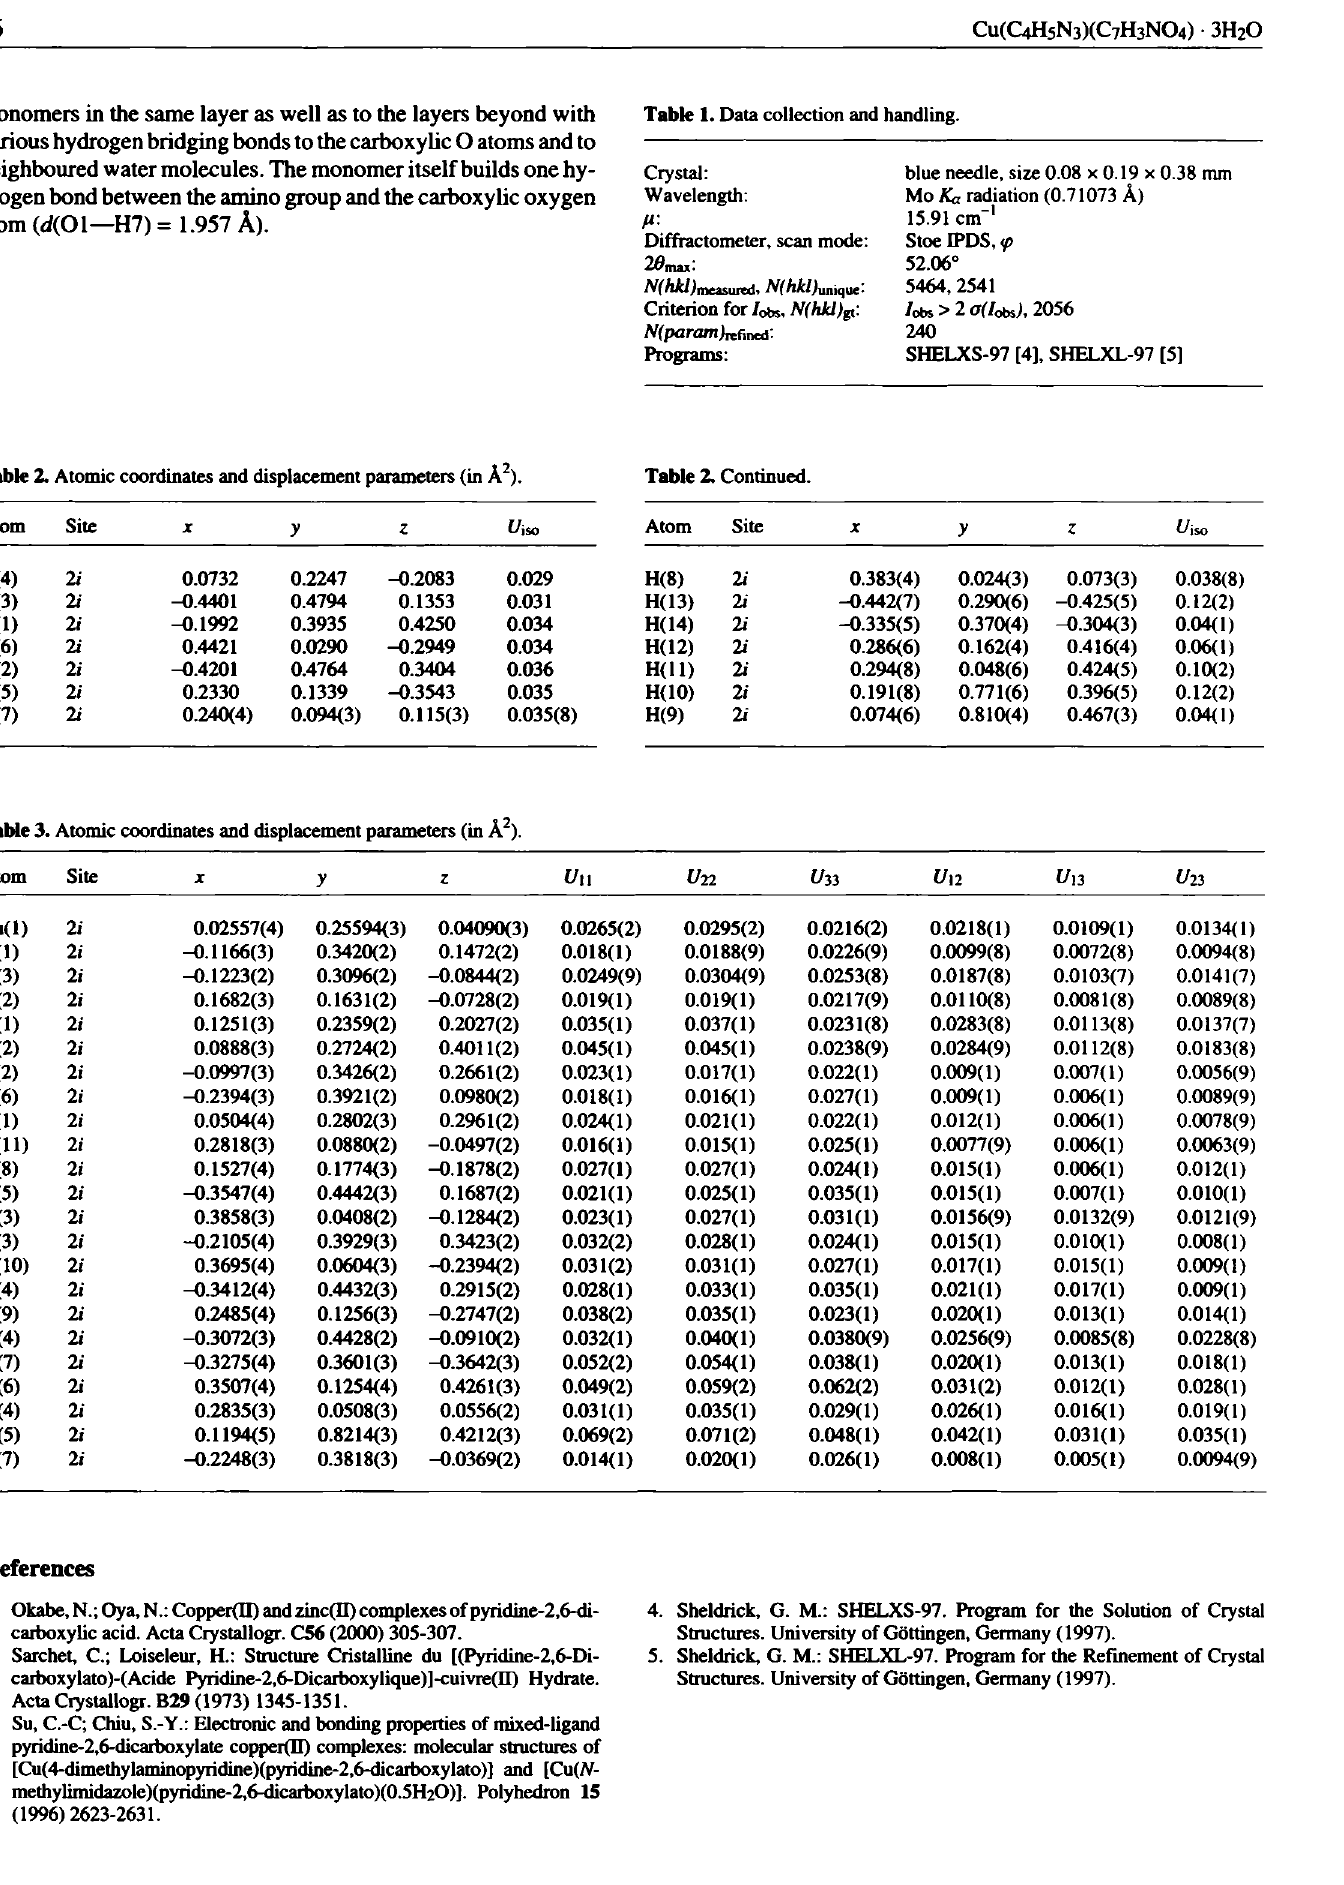
Table 3. Atomic coordinates and displacement parameters (in Â 2